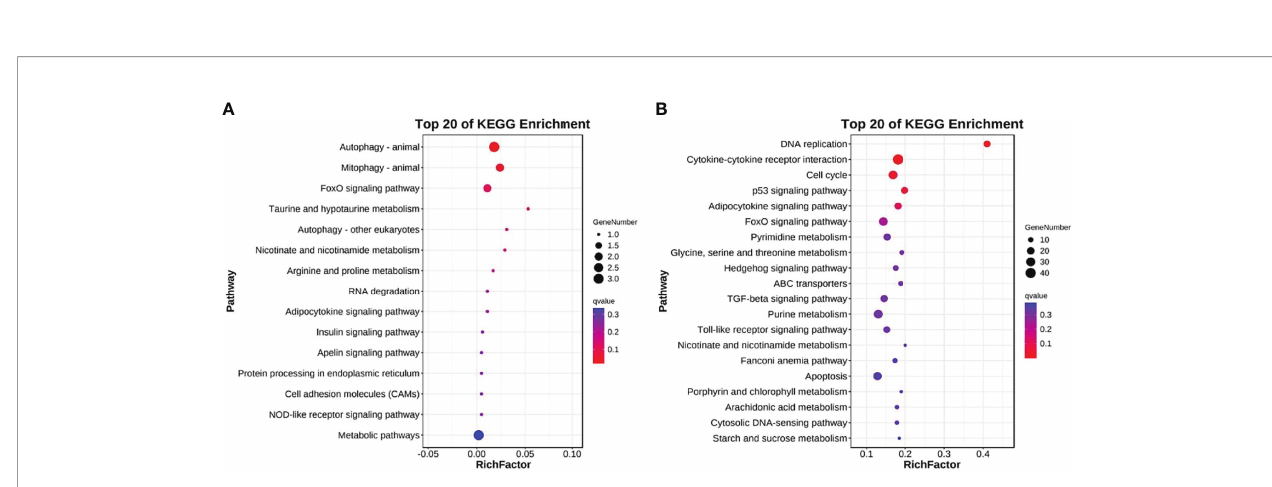
FIGURE 4 | Top 20 KEGG enriched DEGs after exposure to (A) 0.5 and (B) 5 m g/L Del compared to the control group (0 m g/L Del). The vertical and horizontal axes represent different pathways and rich factors, respectively.